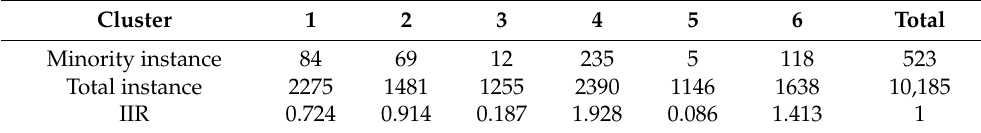
Table 5. The number of minority and total cases, and the IIR (with population RI ratio at 5.1%) for the 6 clusters generated by